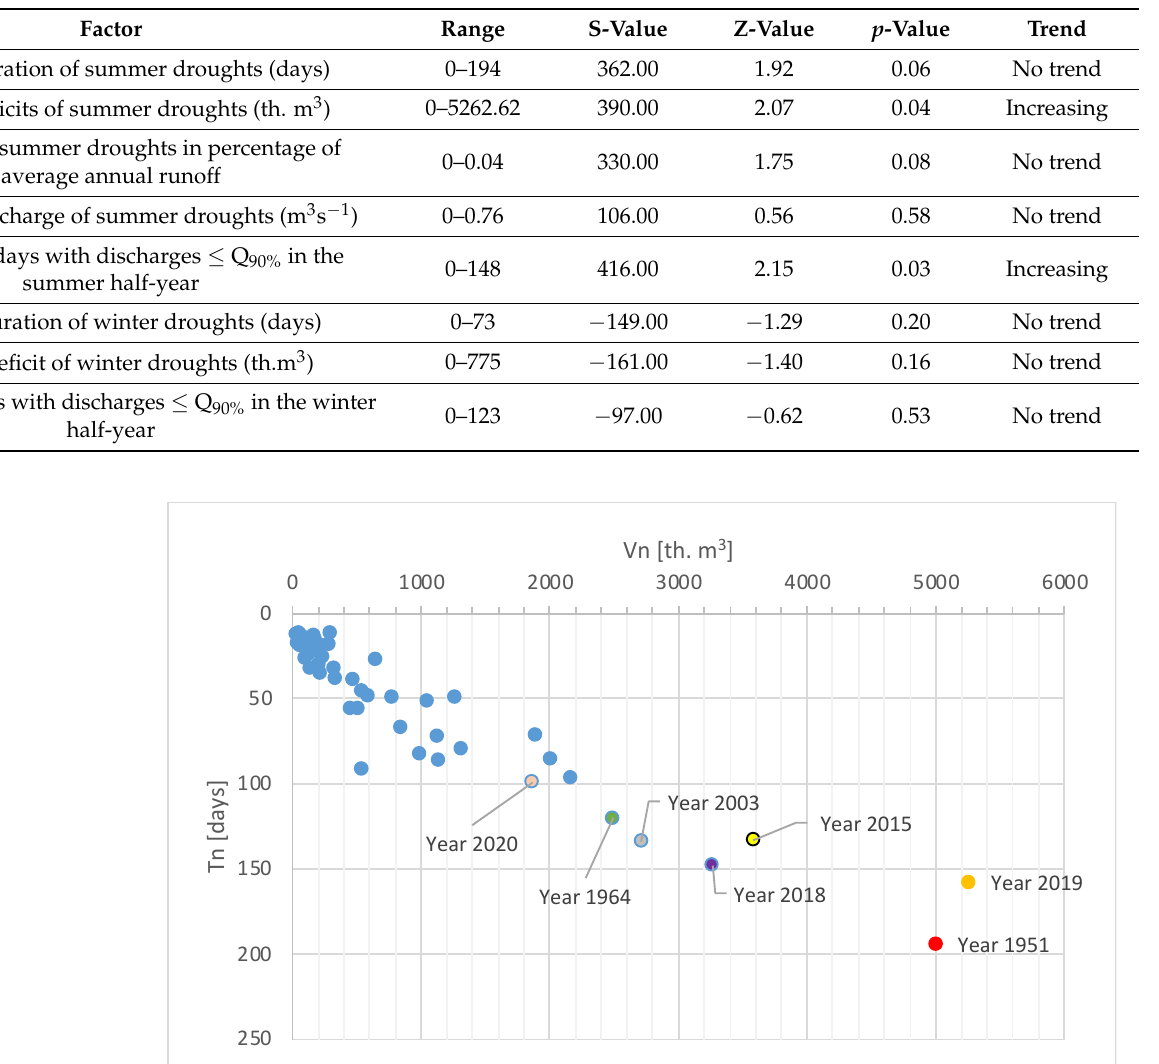
Figure 17. Comparison of streamflow drought in 1951 to the summer streamflow droughts in the 1951*–2020 period at the Narewka gauging station; Annotation: the streamflow drought of 1951 is considered to be a summer event.